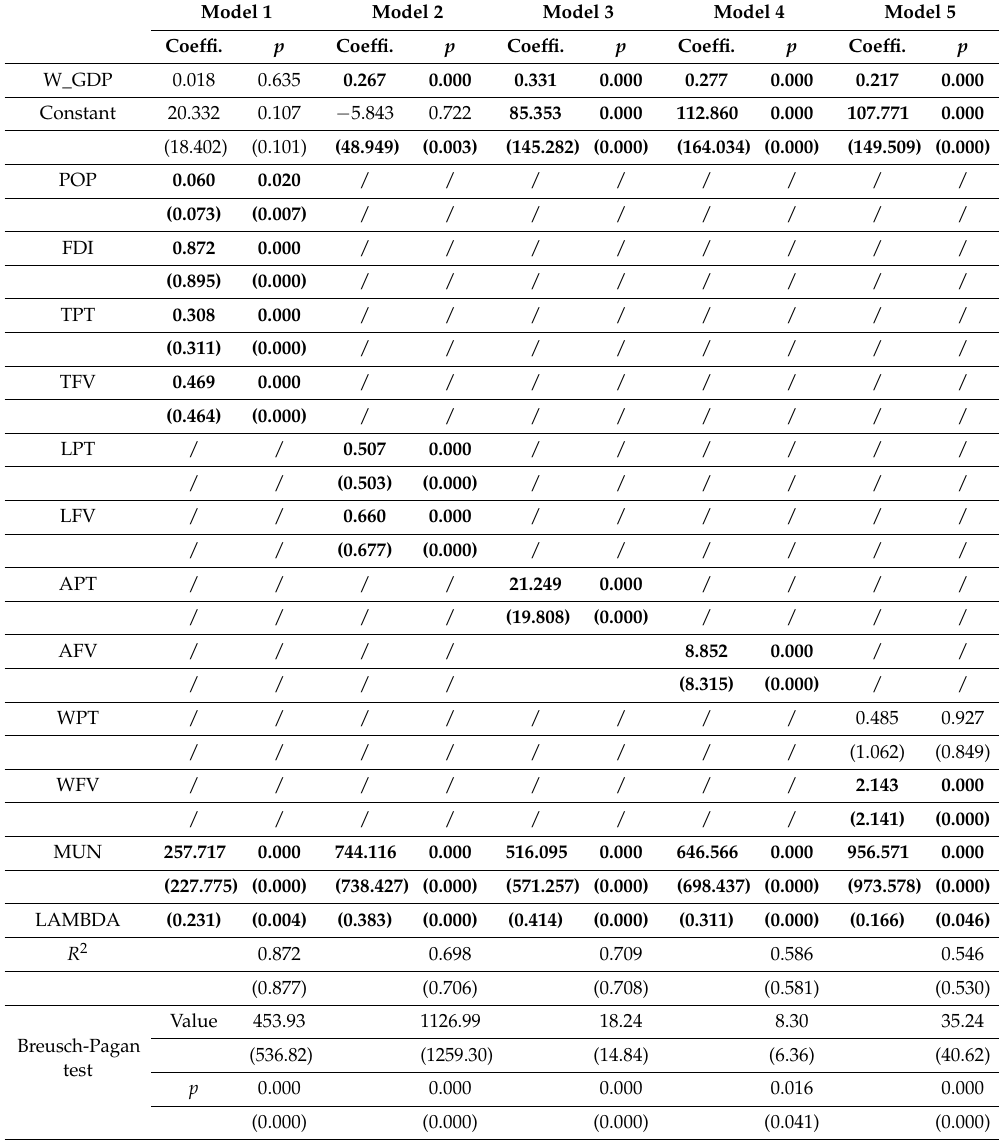
Table 5. SLM/SEM estimation results at the national